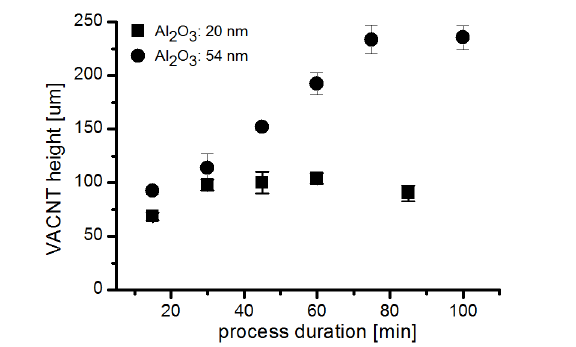
Figure 6. Forest height of VACNT with increasing process duration grown by CVD from nickel foil substrates, wet-chemically coated with different thicknesses of Al 2 O 3 buffer layer ( ■ Al 2 O 3 : 20 nm, ● Al 2 O 3 : 54 nm), and 40 nm Fe x Co y O z catalyst